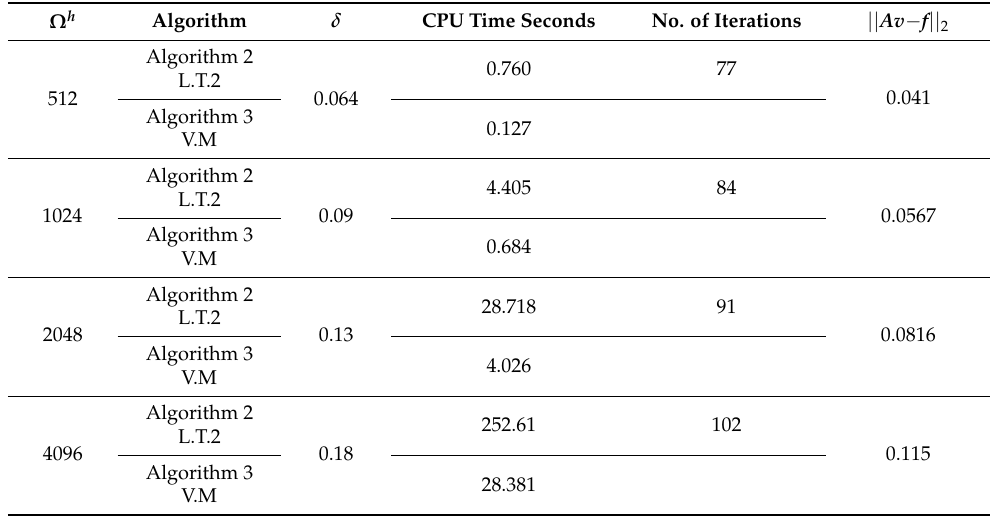
Table 2. Results for initial value problem in different Ω h .